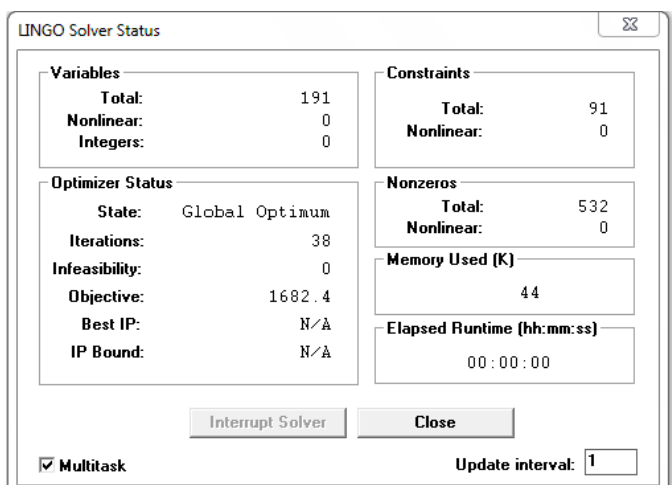
Figure 3: Software Lingo execution